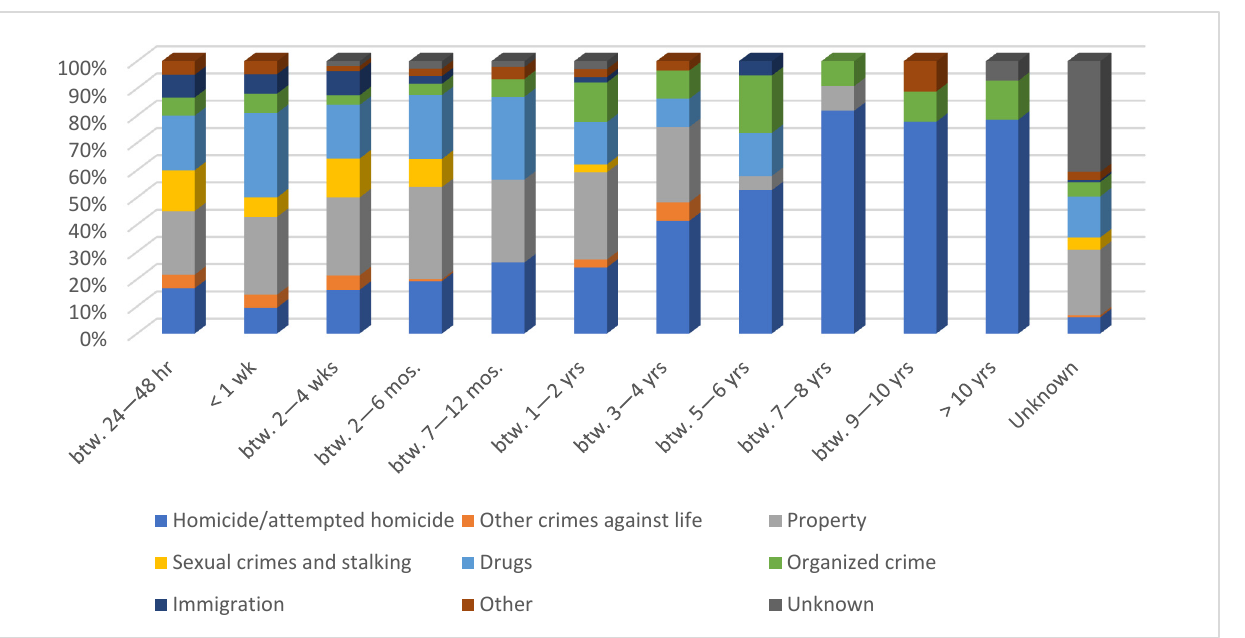
Figure 1. Type of crime and suicide percentage, considering the imprisonment length.